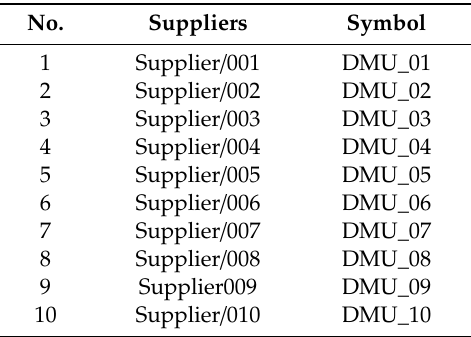
Table 3. Symbol of 10 oil suppliers (DMU: decision-making units).